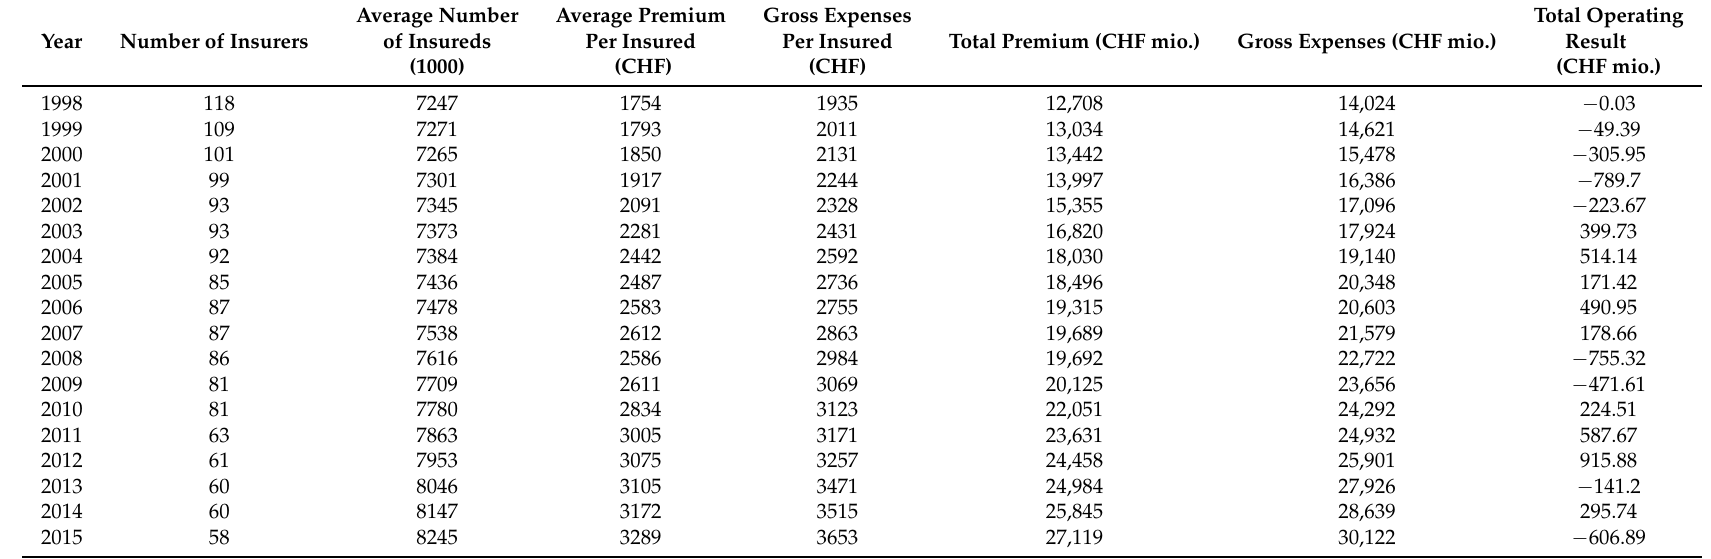
Table A1. Key figures on the Swiss health insurance market from 1998 to